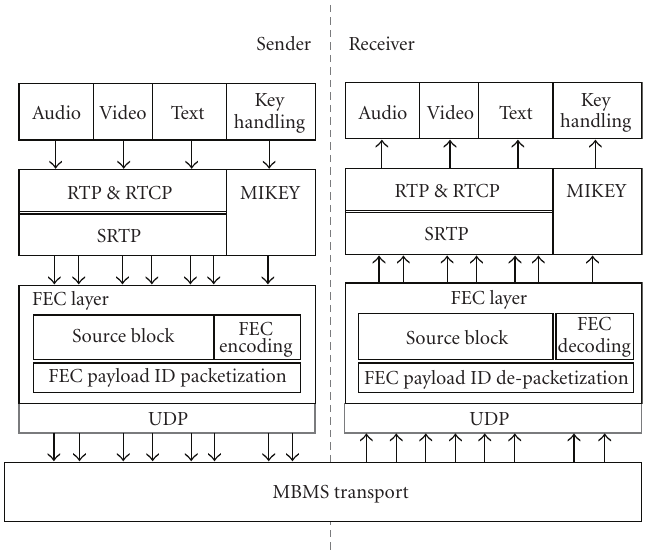
Figure 12: FEC mechanism for the streaming delivery method interaction diagram.